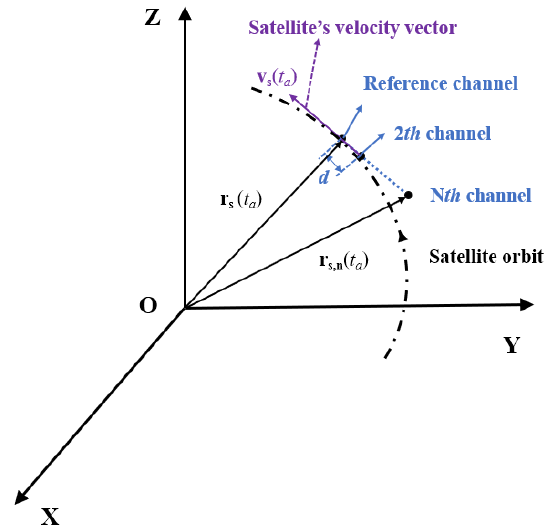
where r t ( t a ) = [ x t ( t a ) y t ( t a ) z t ( t a )] and r s ( t a ) = [ x s ( t a ) y s ( t a ) z s ( t a )] are the position vectors of the moving target and the satellite, respectively, and |.| indicates modulo operation to the vector. In this paper, the bold letters represent vectors, and the letters of italic fonts represent the norms of vectors.